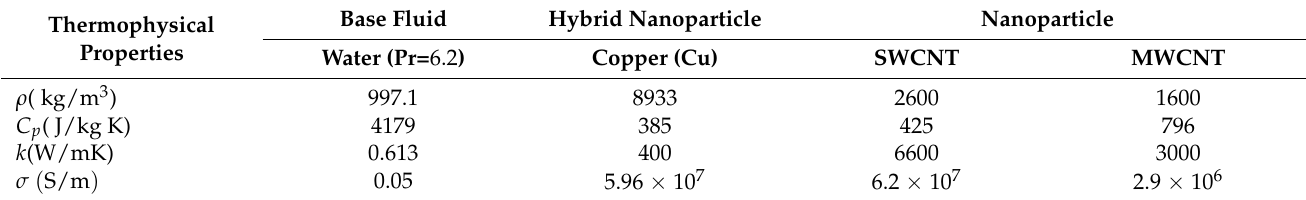
Table 2. The thermophysical properties of nanoparticle, hybrid nanoparticle, and fluid.